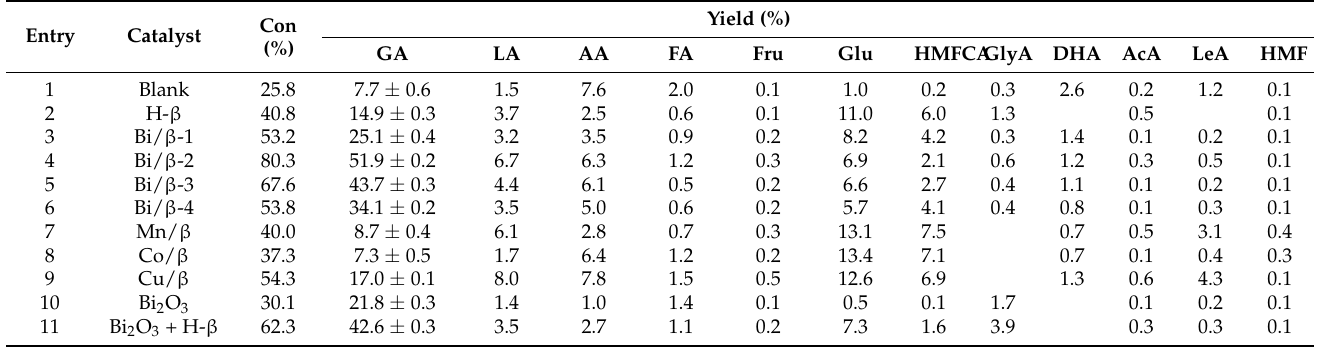
Table 3. The conversion yields of cellulose into organic acids over various